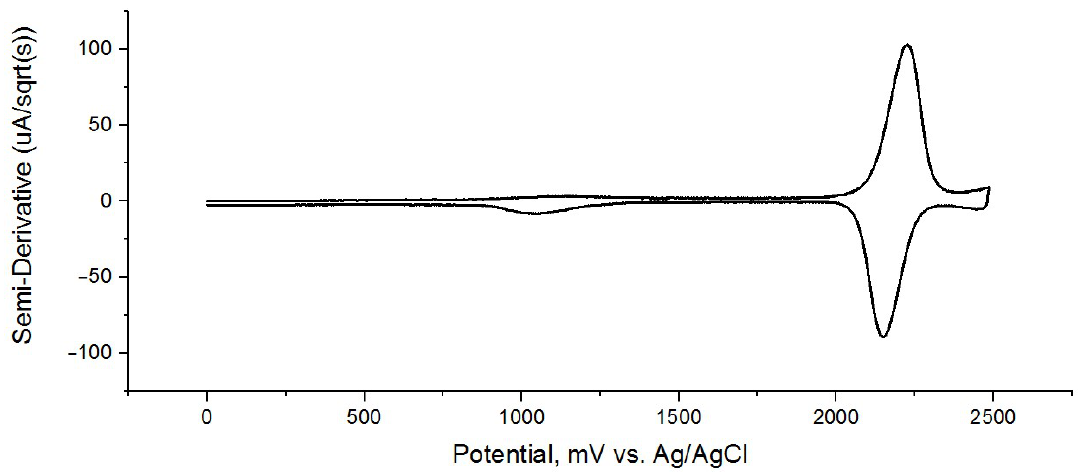
10 of 15 Figure 10. Cyclic voltammogram for oxidation of coordination polymer 2 . Conditions: CPE [graph- ite + ionic liquid + CP 2 ] in 2 mL CH 3 CN (0.1 M Bu 4 NBF 4 ). The ferrocene fragment of CP 2 in the solid state reversibly oxidizes at 2.34 V vs. Ag/AgCl with ΔE = 121 mV, that is, at more positive potentials comparable to pure ferro-